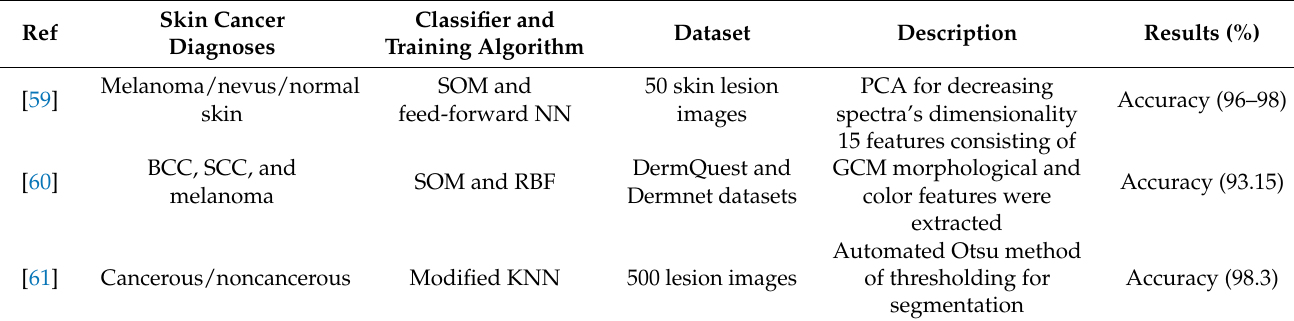
Table 7. A comparative analysis of skin cancer detection using KNN-based